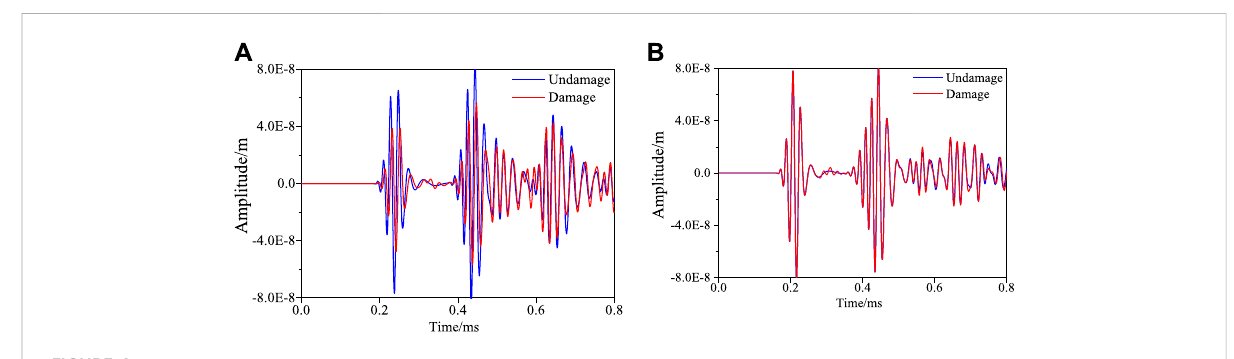
FIGURE 4 Signal comparison before and after damage. (A) S1 – S7 single sensing channel. (B) S5 − S9 single sensing